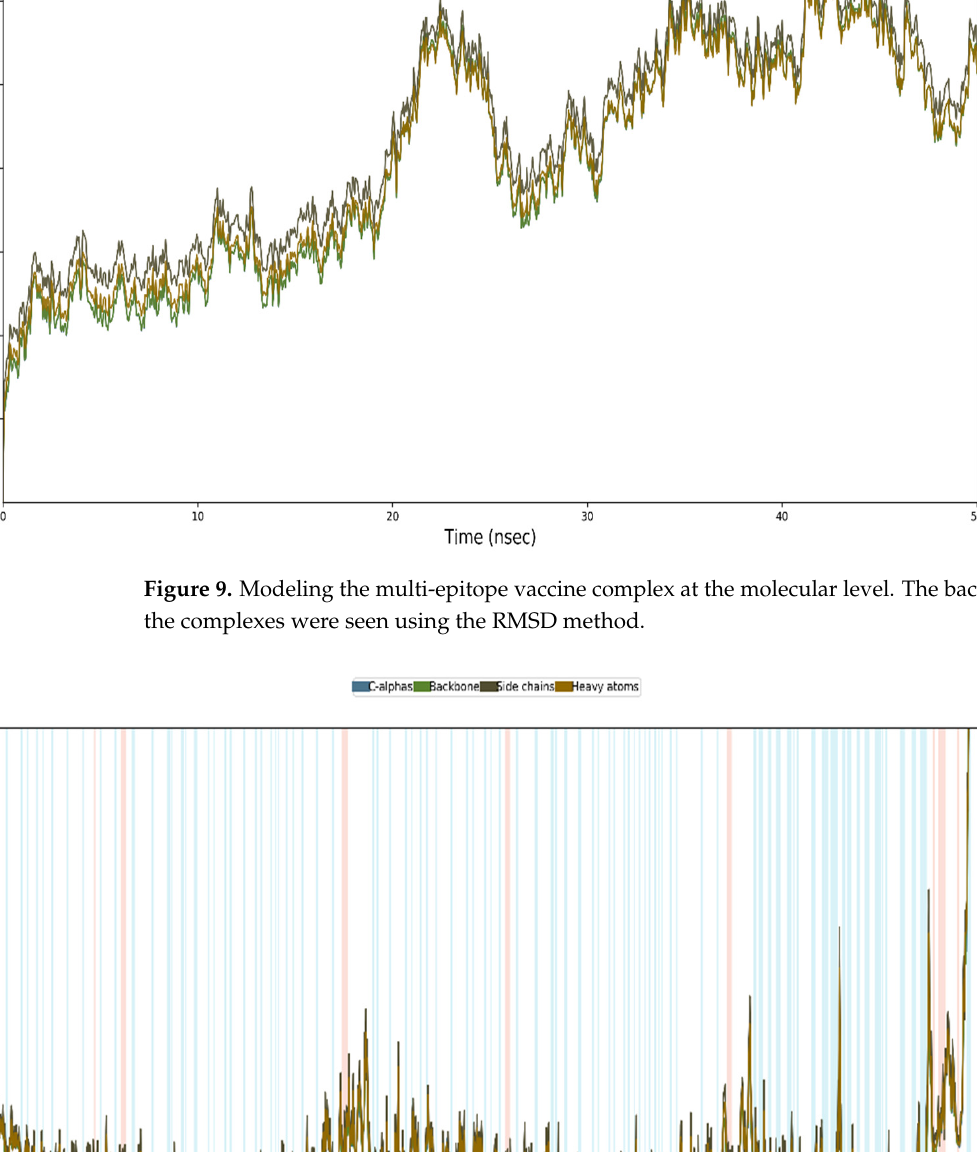
Figure 11. Normal mode analysis of Vaccine-TLR4 complex. The protein-protein complex’s stability was studied using deformability ( A ), B-factor ( B ), eigenvalue ( C ), variance ( D ), covariance ( E ), and elastic network ( F ) analysis.